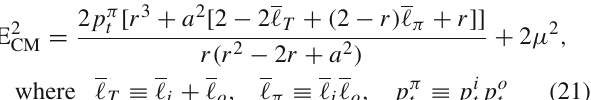
Fig. 13 Illustration of (cid:4) -modes. Upper panel : the function W = Fig. 12 Illustration of K (cid:4) -modes. Upper panel shows the function (cid:6) (cid:6) ¯ (cid:4) . The ln [ V ef f ((cid:4)) ] , in Eq. (7), for different values of the fluid specific angular W ¯ (cid:4) = ln [ V ef f ((cid:4)) ] ¯ (cid:4) , in Eq. (7), at constant angular momentum momentum (cid:4) . (cid:4) -range, maximum range of variation of the (cid:4) parameter, effects of modes, K (cid:4) ∈ [ K min , K max ] are illustrated by the range of (cid:4) ∈ [ (cid:4) ,(cid:4) [≡ [ (cid:4) ,(cid:4) [ , is light-gray colored. Black-thick curve mso mbo min sup parameters and variables variations (shaded-labeled regions): K -range marks K crit for the fixed value BH dimensionless spin a / M – see also (dark gray), inner torus edge r in -range (light-gray), outer torus margin Fig. 5. Bottom panel : torus profiles, corresponding to different values of r out -range (white). Arrows indicate the ranges. The torus maximum (cid:4) ∈ (cid:4) -range. r + (cid:10) is the outer ergosurface, black region marks the range elongation λ × , following the K (cid:4) -modes is also shown. r cent is the max- r ≤ r + where r + is the outer BH horizon. The analysis of (cid:4) -modes imum pressure point of the torus, r + (cid:10) is the outer ergosurface, black of each torus of the RAD must be combined with K -modes (cid:4) -modes region marks the range r ≤ r + where r + the the outer BH horizon. In for any other RAD component; (cid:4) -modes are associated to shifts related the RAD context, the study of K (cid:4) -modes for one torus, must be coupled points on the K crit curve (at fixed a / M ) (each point sets a different with the K (cid:4) -modes for any other component of the aggregates and with minimum and maximum pressure point, each point of the such a couple the (cid:4) -modes – Fig. 13. Bottom panel : some torus profiles corresponding on K crit sets different angular momenta. On the other hand only for to different values of K . Light-gray circular region corresponds to the accreting tori, curves K crit = constant fix r × and r out of the accreting r in -range. – See also Fig. 5 torus correspondent to one fixed value of specific angular momentum- see also Figs. 5, 6, 8, 9, 10 and